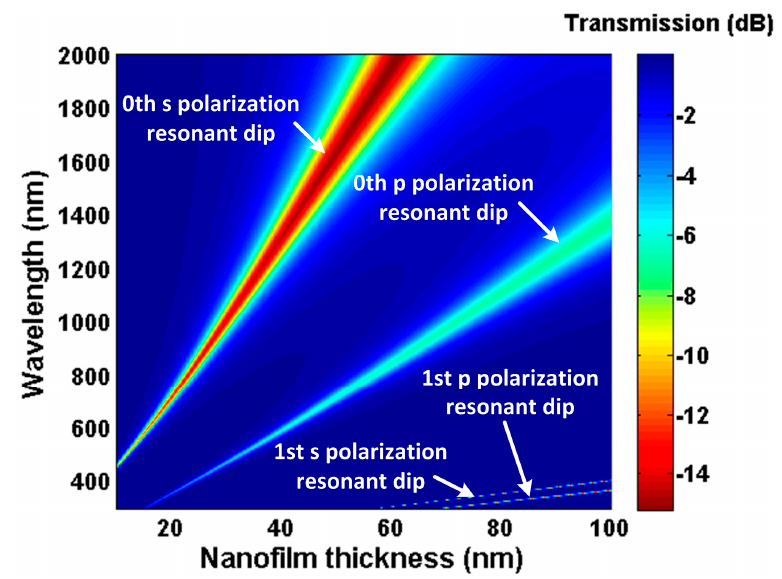
Figure 2. Transmission spectra as a function of the TiO 2 film thickness in water (1.33).